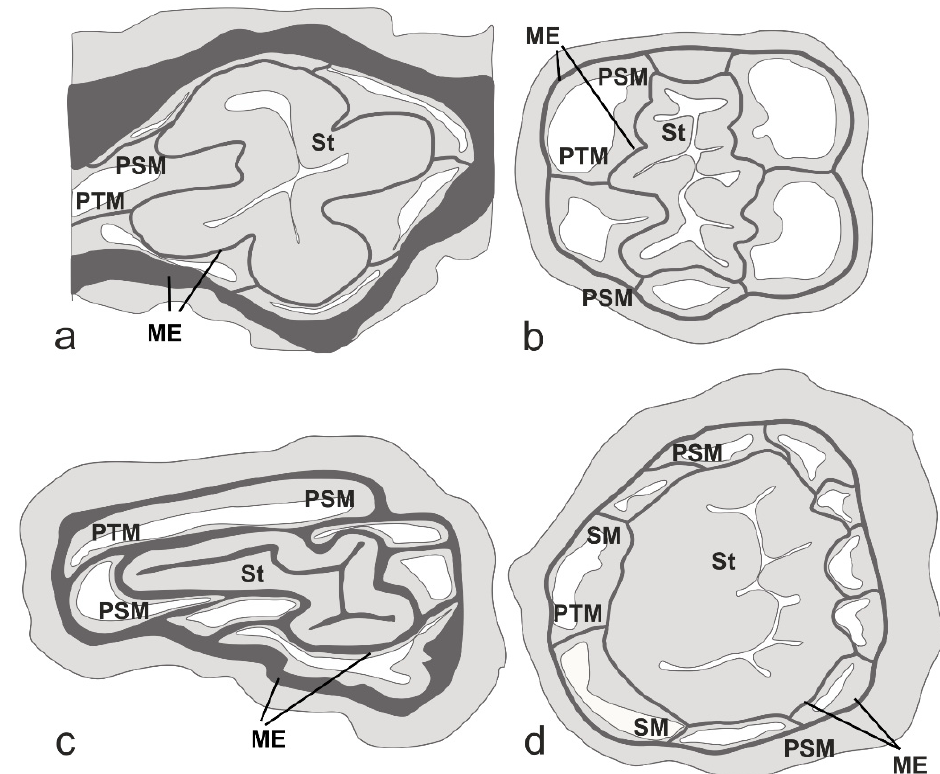
Figure 6. Schematic sections of the oral cone of polyps of Cladopathidae ( a – c ) and Schizopathidae ( d ). ( a ) Abyssopathes lyra (same section as shown in Figure 5a); ( b ) Hexapathes heterosticha Kinoshita, 1910 [30]; ( c ) Cladopathes plumosa [11]; ( d ) Parantipathes sp. (North Atlantic); St—stomodeum; PSM—